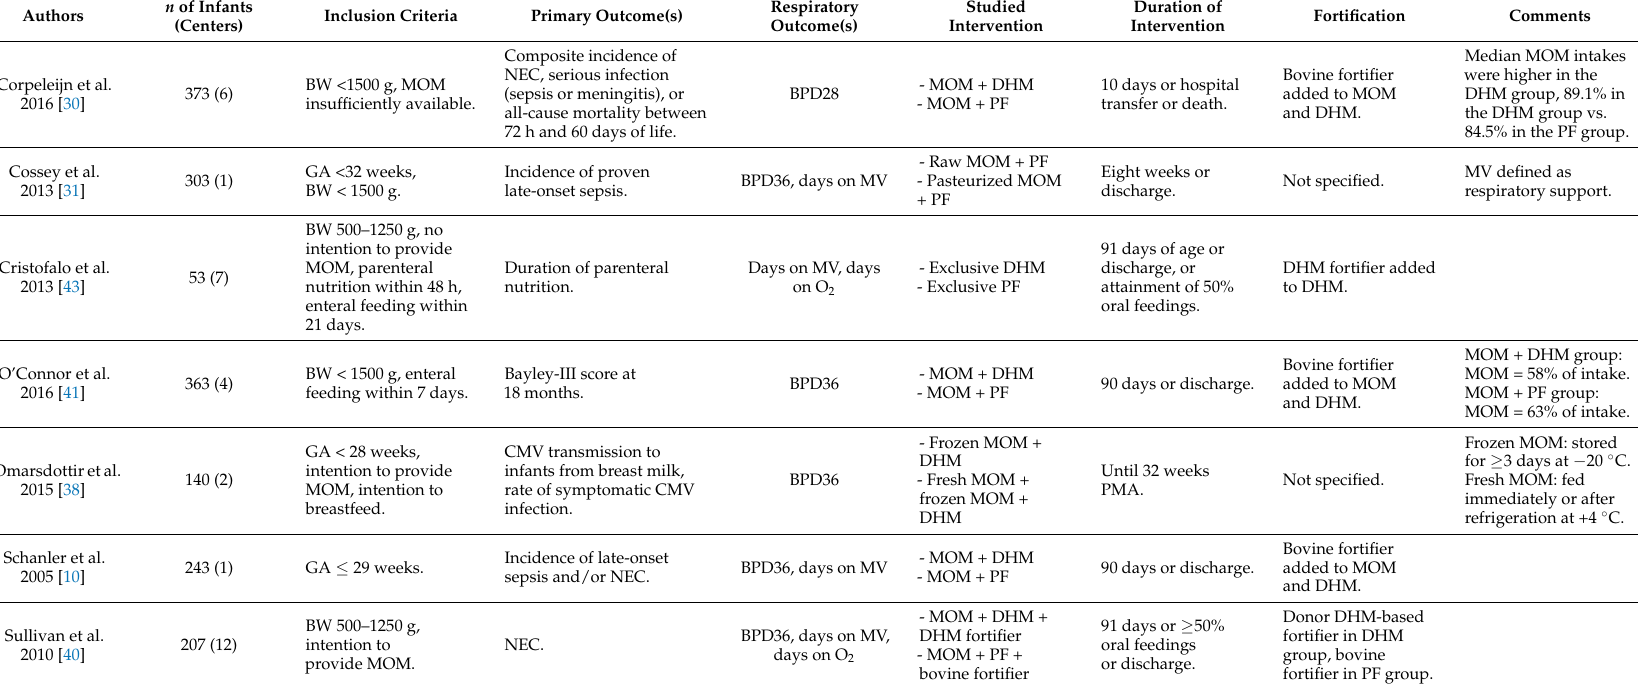
Table 1. Synoptic table of characteristics of included randomized controlled